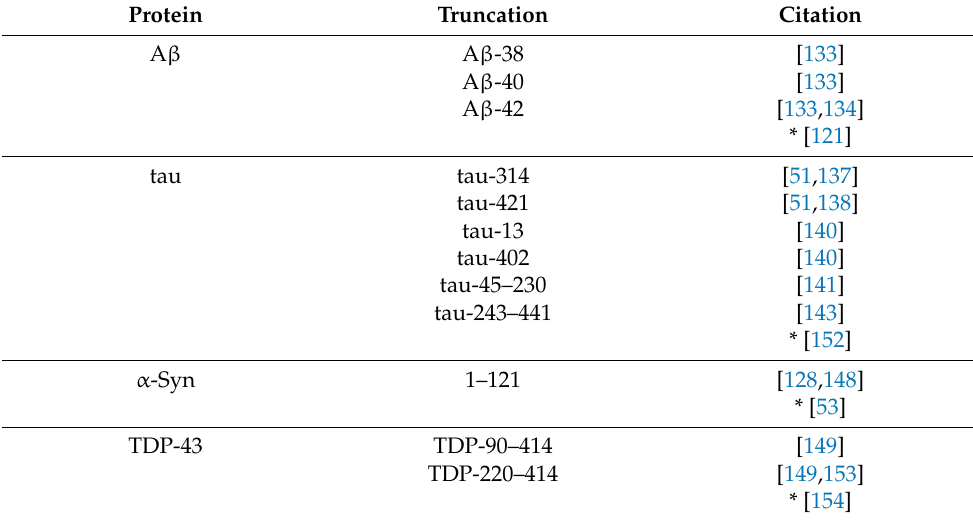
Table 3. Truncations associated with NDs.